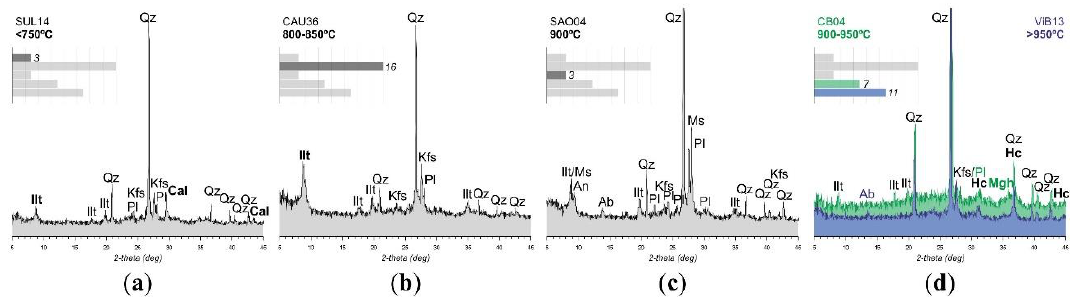
Figure 3. Diffractograms of representative samples for different temperature ranges: <750 °C with stable phases of illite and calcite ( a ), 800–850 °C still showing illite peaks ( b ), c. 900 °C with an increasing amount of plagioclase ( c ) and >900 °C when hercynite is forming particularly in a reducing atmosphere; two different fabrics are represented for this range, with and without maghemite ( d ). The number of samples per mineral fabric compared against the total amount of 40 samples is included. Mineral abbreviations after Whitney and Evans [55]: Cal (Calcite), Ilt (Illite), Kfs (Potassium feldspar), (Mgh) Maghemite, Ms (Muscovite), Pl (Plagioclase) and Qz (Quartz).